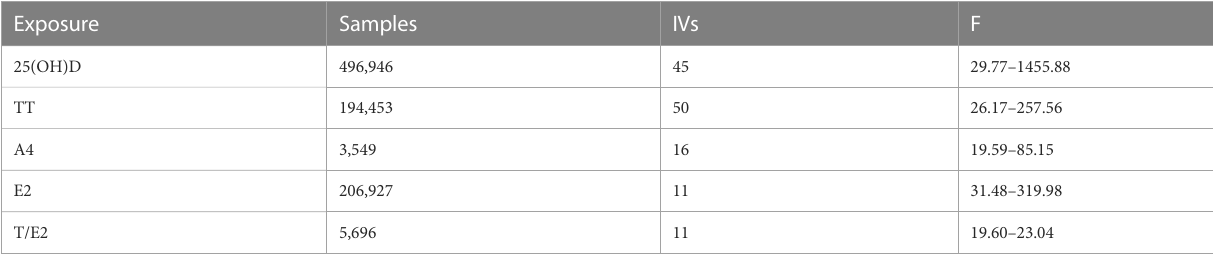
TABLE 1 Selection of IVs after quality control.